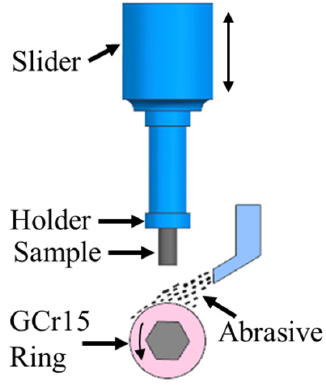
Figure 2. Illustration diagram of the impact wear tester.